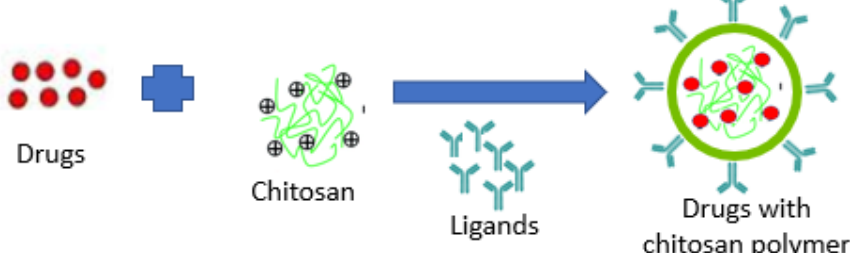
Figure 2. Schematic illustration of target-drug chitosan nanopolymer.